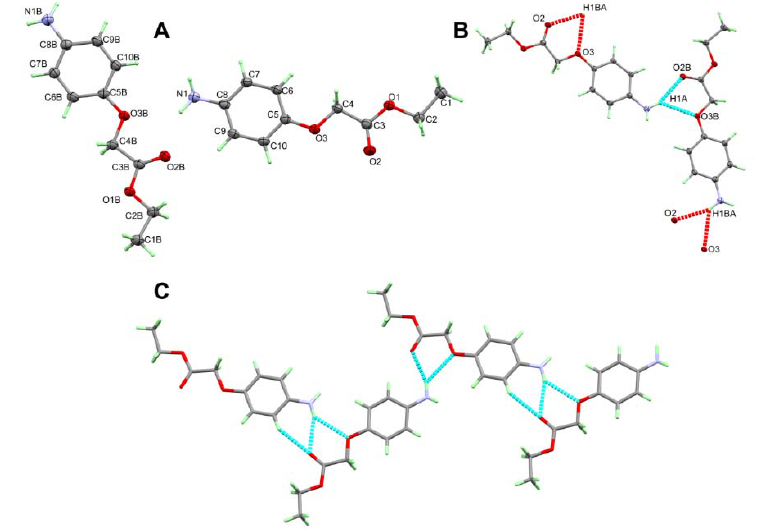
Figure 3. X-ray structure ( A ), hydrogen bonds ( B ), and part of packing scheme ( C ) of 4